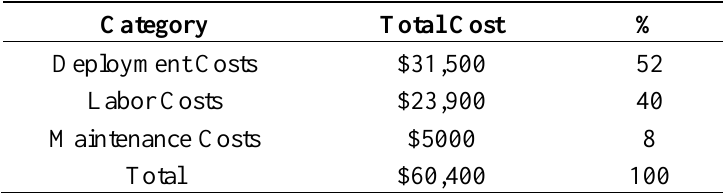
Table 6. Summary of network deployment costs and the total labor and maintenance costs for four years of network